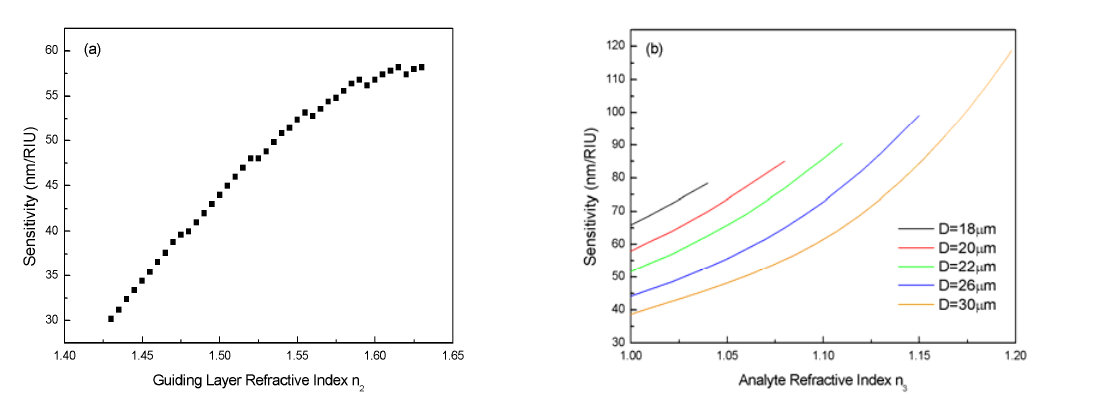
=1.426, n =1.47, n =1.0, d =0.4 μ 1 2 3